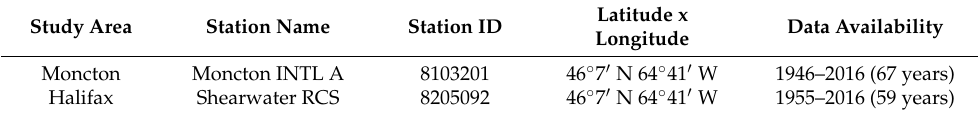
Table 1. Stations selected for the study.